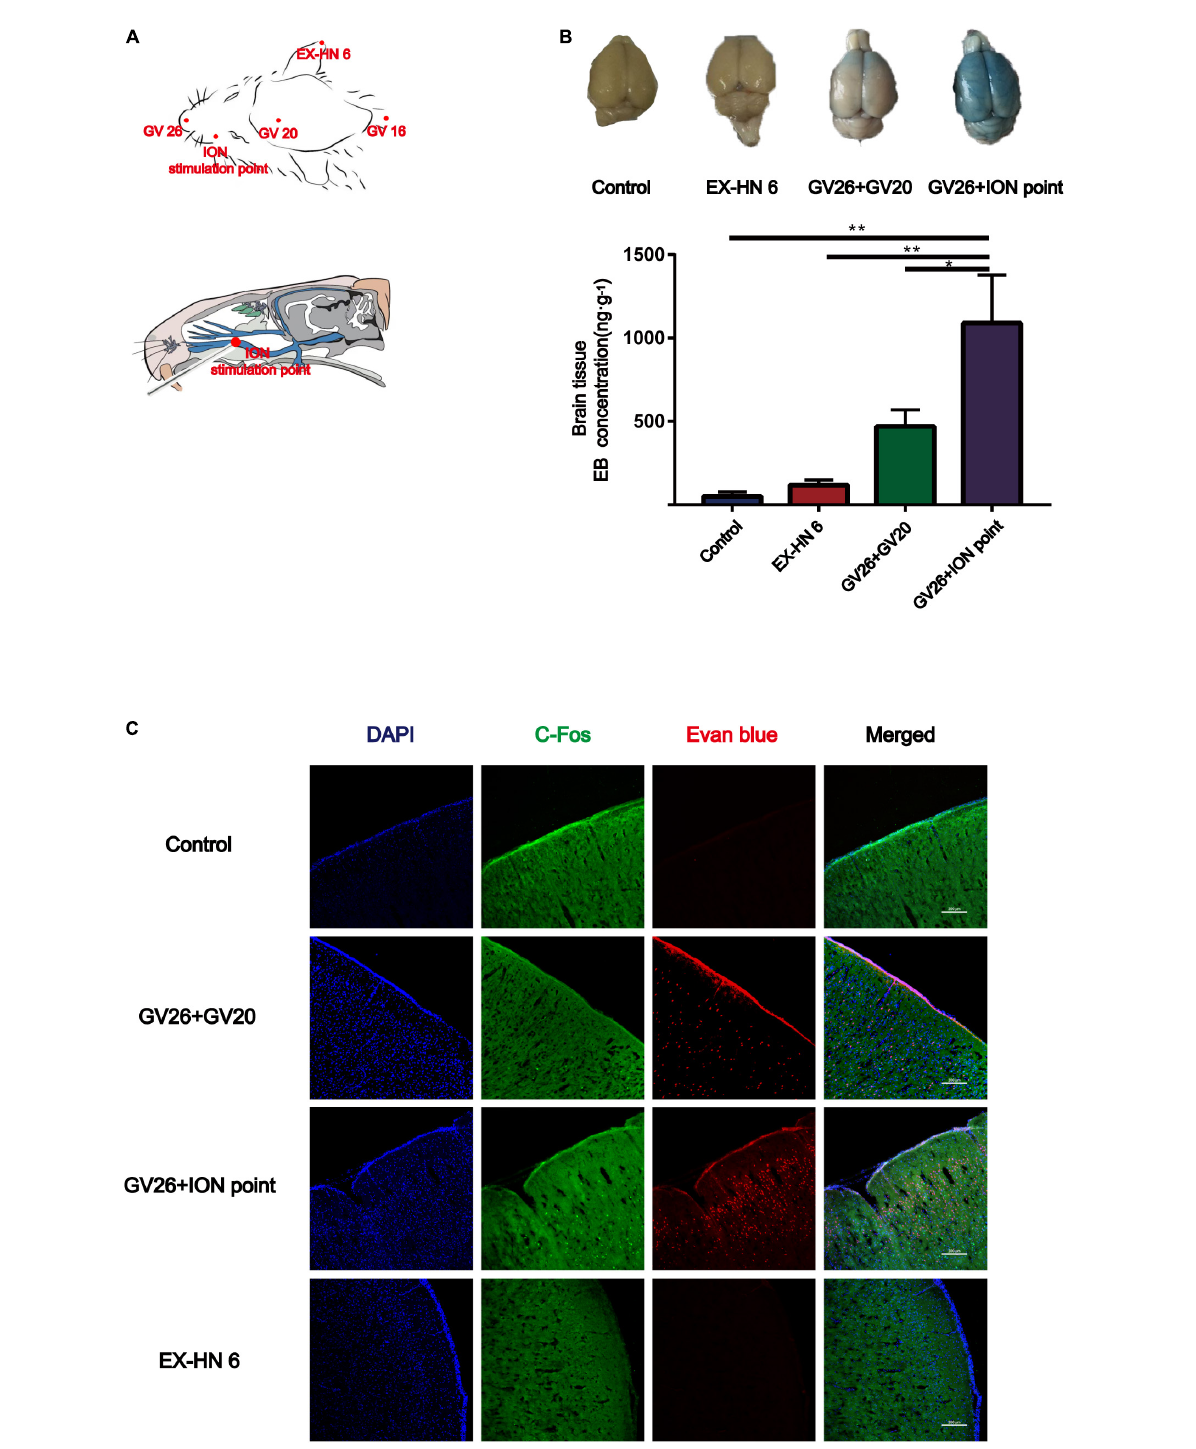
FIGURE2 In the head region, EA stimulation of the trigeminal nerve promoted BBB opening more significantly. (A) Schematic diagram of the head acupoint and infraorbital nerve (ION) stimulation point (the largest branch of the trigeminal nerve, located in the upper 1/3 of the lower margin of the zygomatic bone of the rat right cheek, close to the back of the nose). (B) The upper part shows the degree of EB penetration in the brain of each group under naked eye observation, the cortex of each group; ** P < 0.01, GV26 + ION point group vs. control group and EX-HN6 group; * P < 0.05, GV26 + ION point group vs. GV20 + GV26 group, n = 6/group. (C) EA of head different acupoints, cerebral cortex EB, and c-Fos fluorescence expression. The GV26 + ION point group had the most significant